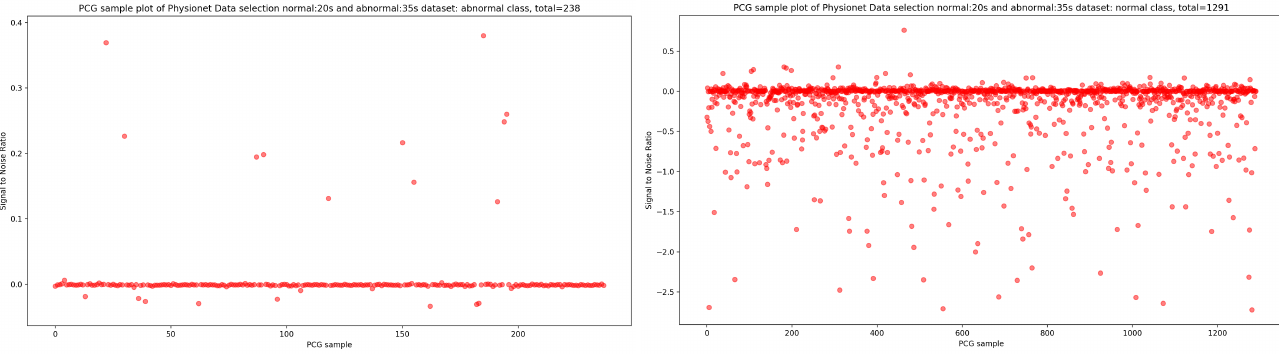
Figure 7. The PCG sample distribution in function of SNR of normal and abnormal classes after KDE duration selection